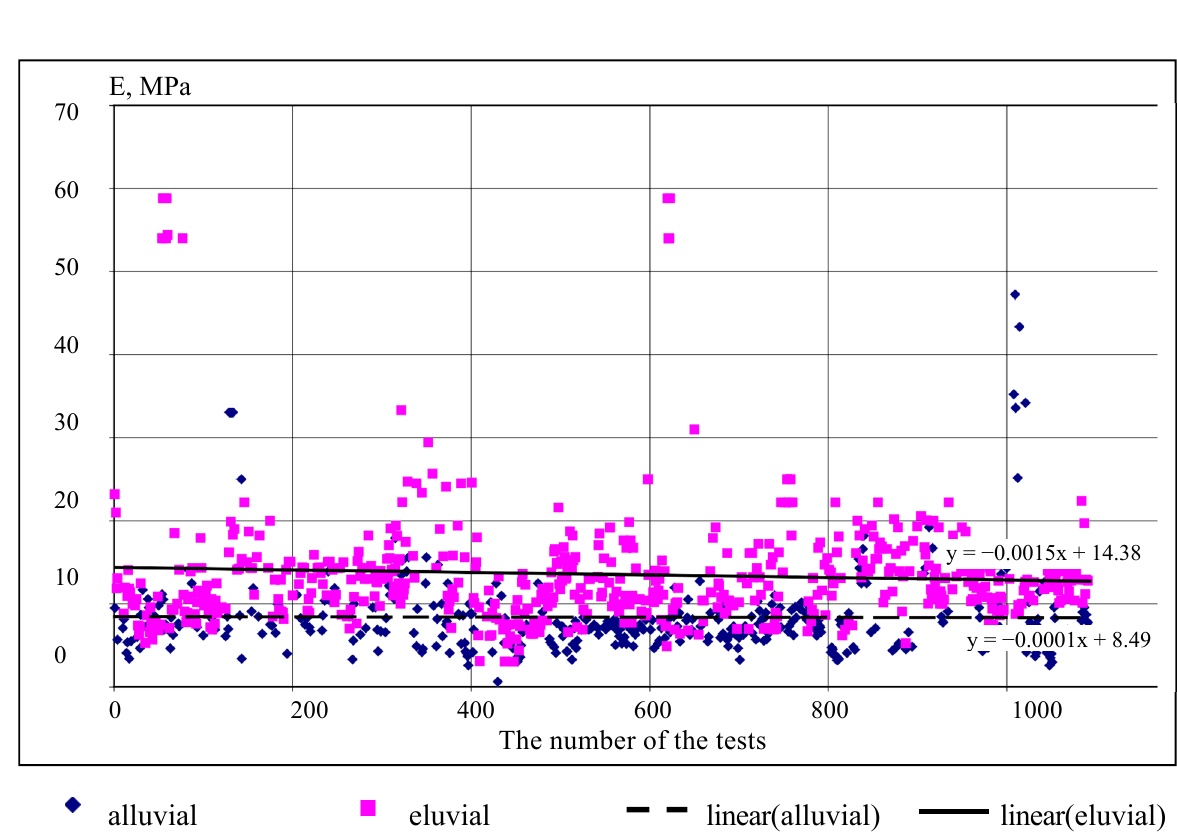
Figure 6 - Deformation modulus E scatter plot for alluvial and eluvial clay deposits Figure 6. Deformation modulus E scatter plot for alluvial and eluvial clay